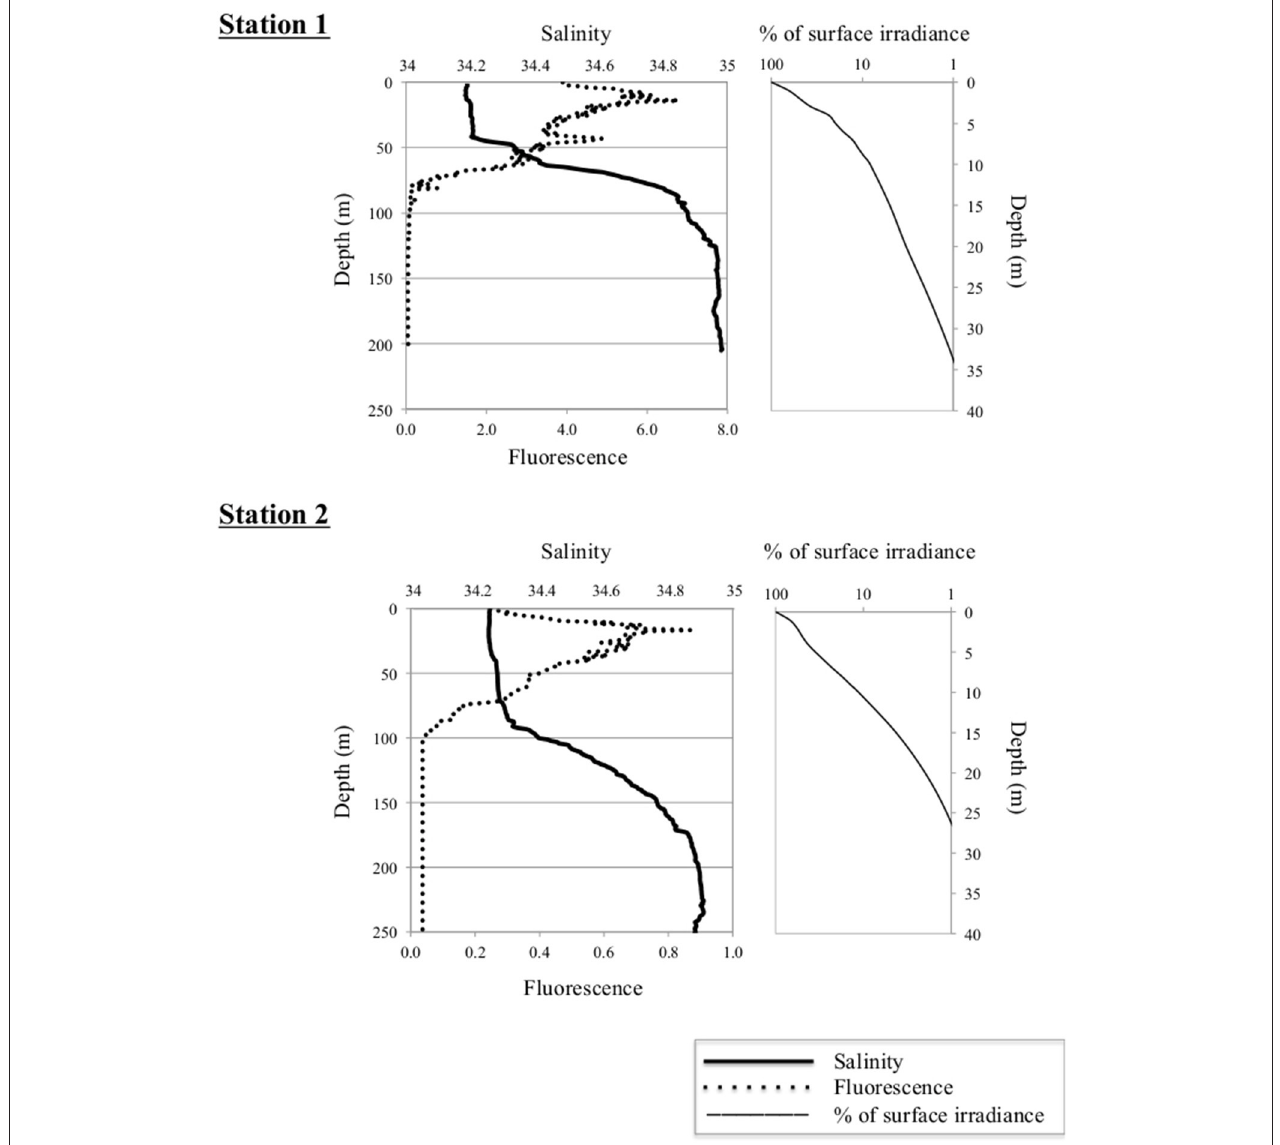
FIGURE 3 | Left panels: Vertical distribution of salinity and in situ fluorescence (mg Chl a m − 3 ) at Stations 1 (upper panel) and 2 (lower panel) . Depth is indicated on the Y-axis. Right panels: Percentage of surface irradiance with depth at the two